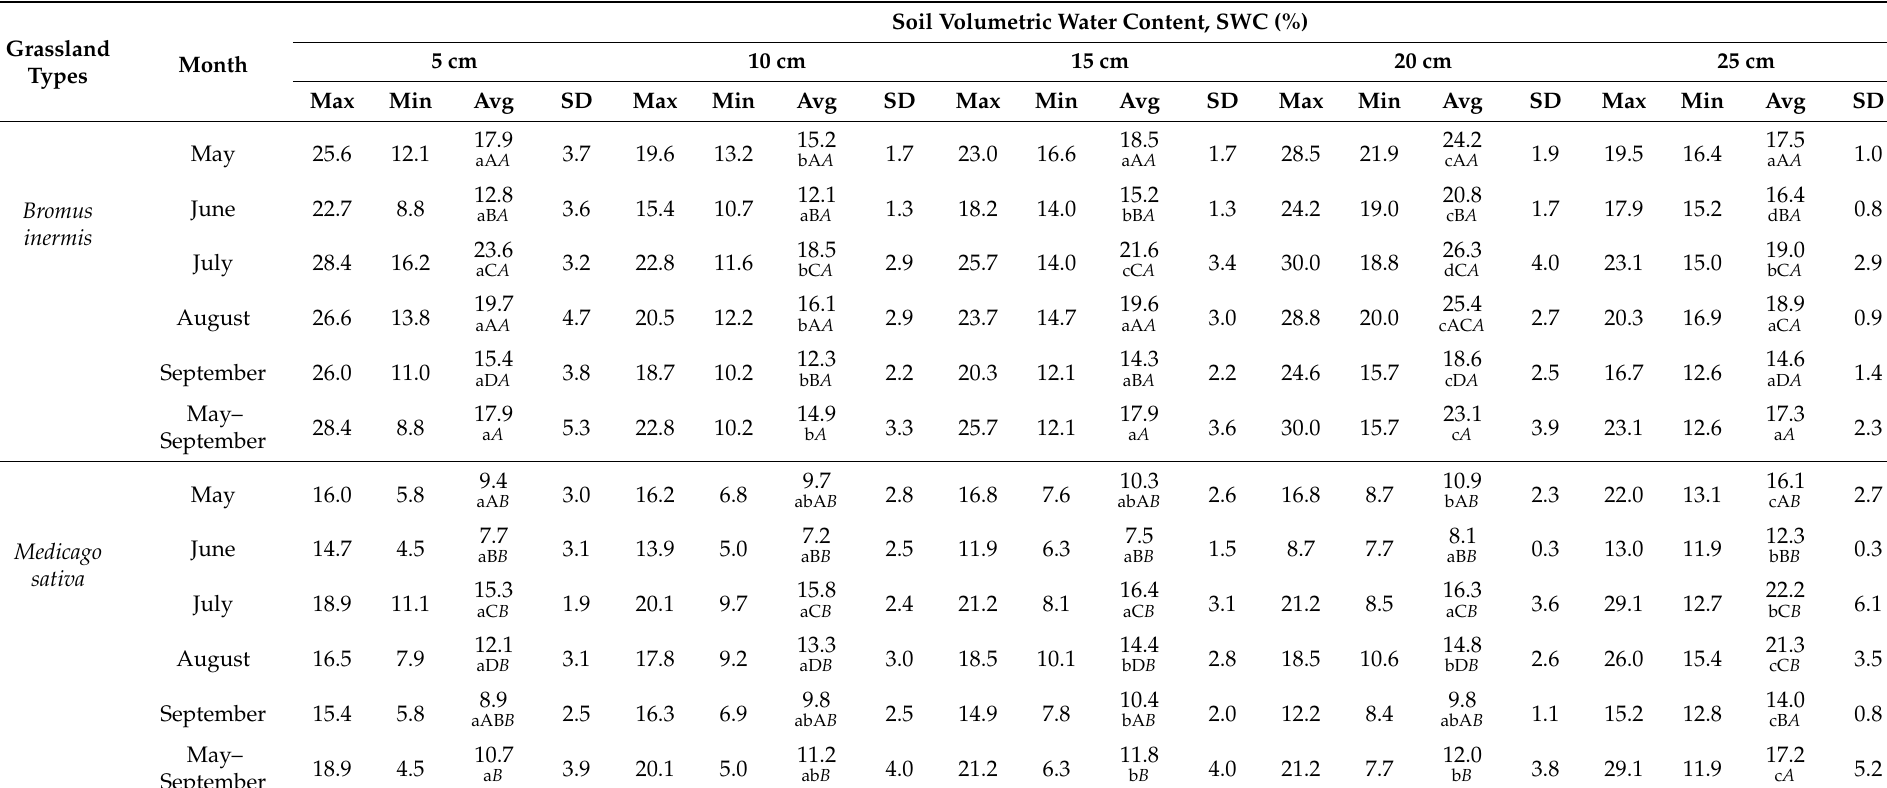
Table 1. Soil water dynamics at different depths from May to September in Bromus inermis and Medicago sativa